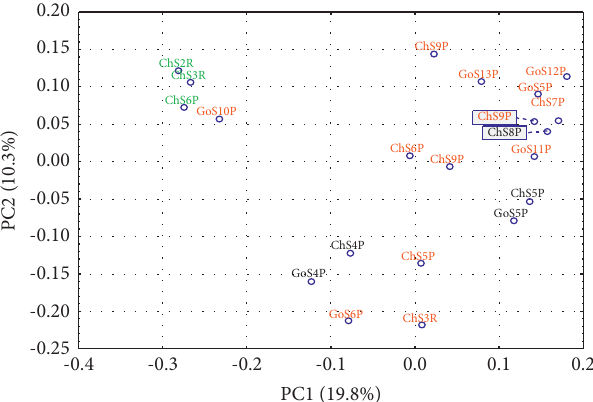
Figure 5: DISTATIS plot of the Cheddar-Gouda group ( n � 21) derived from the sorting data. For cheese codes, the Ch refers to Cheddar and Go refers to Gouda, S1 to S15 refer to the supplier, and P (pasteurized) and R (raw) refer to the milk type. Color codes: black: 1 month; orange: 3 months; green: 6